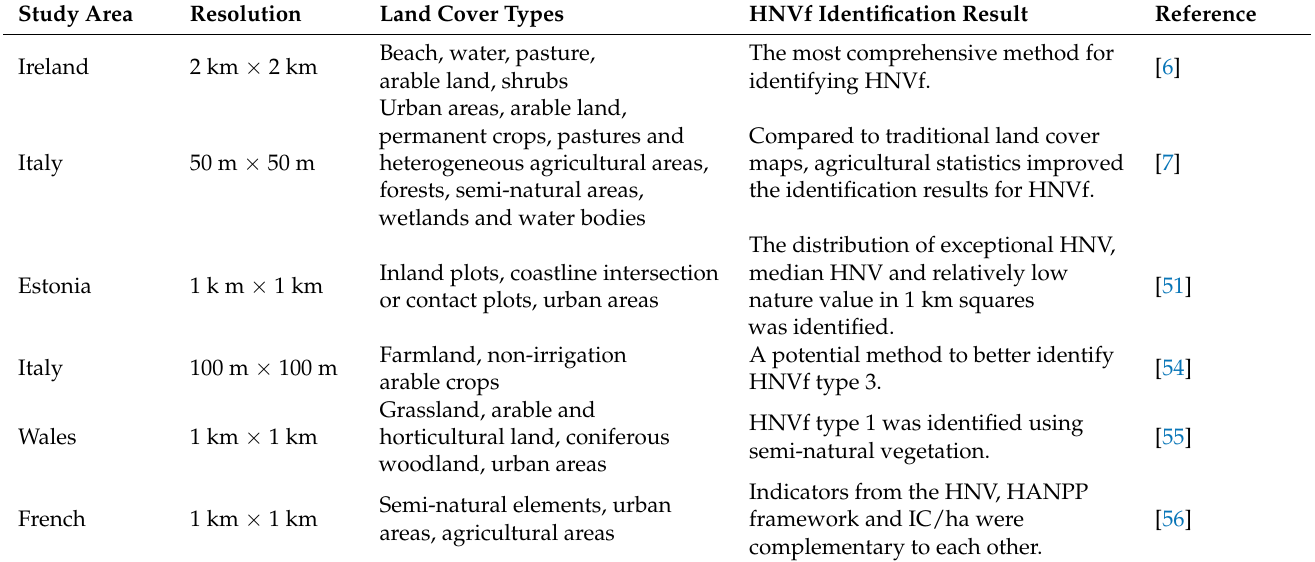
Table 3. Spatial resolution of land cover maps for HNVf